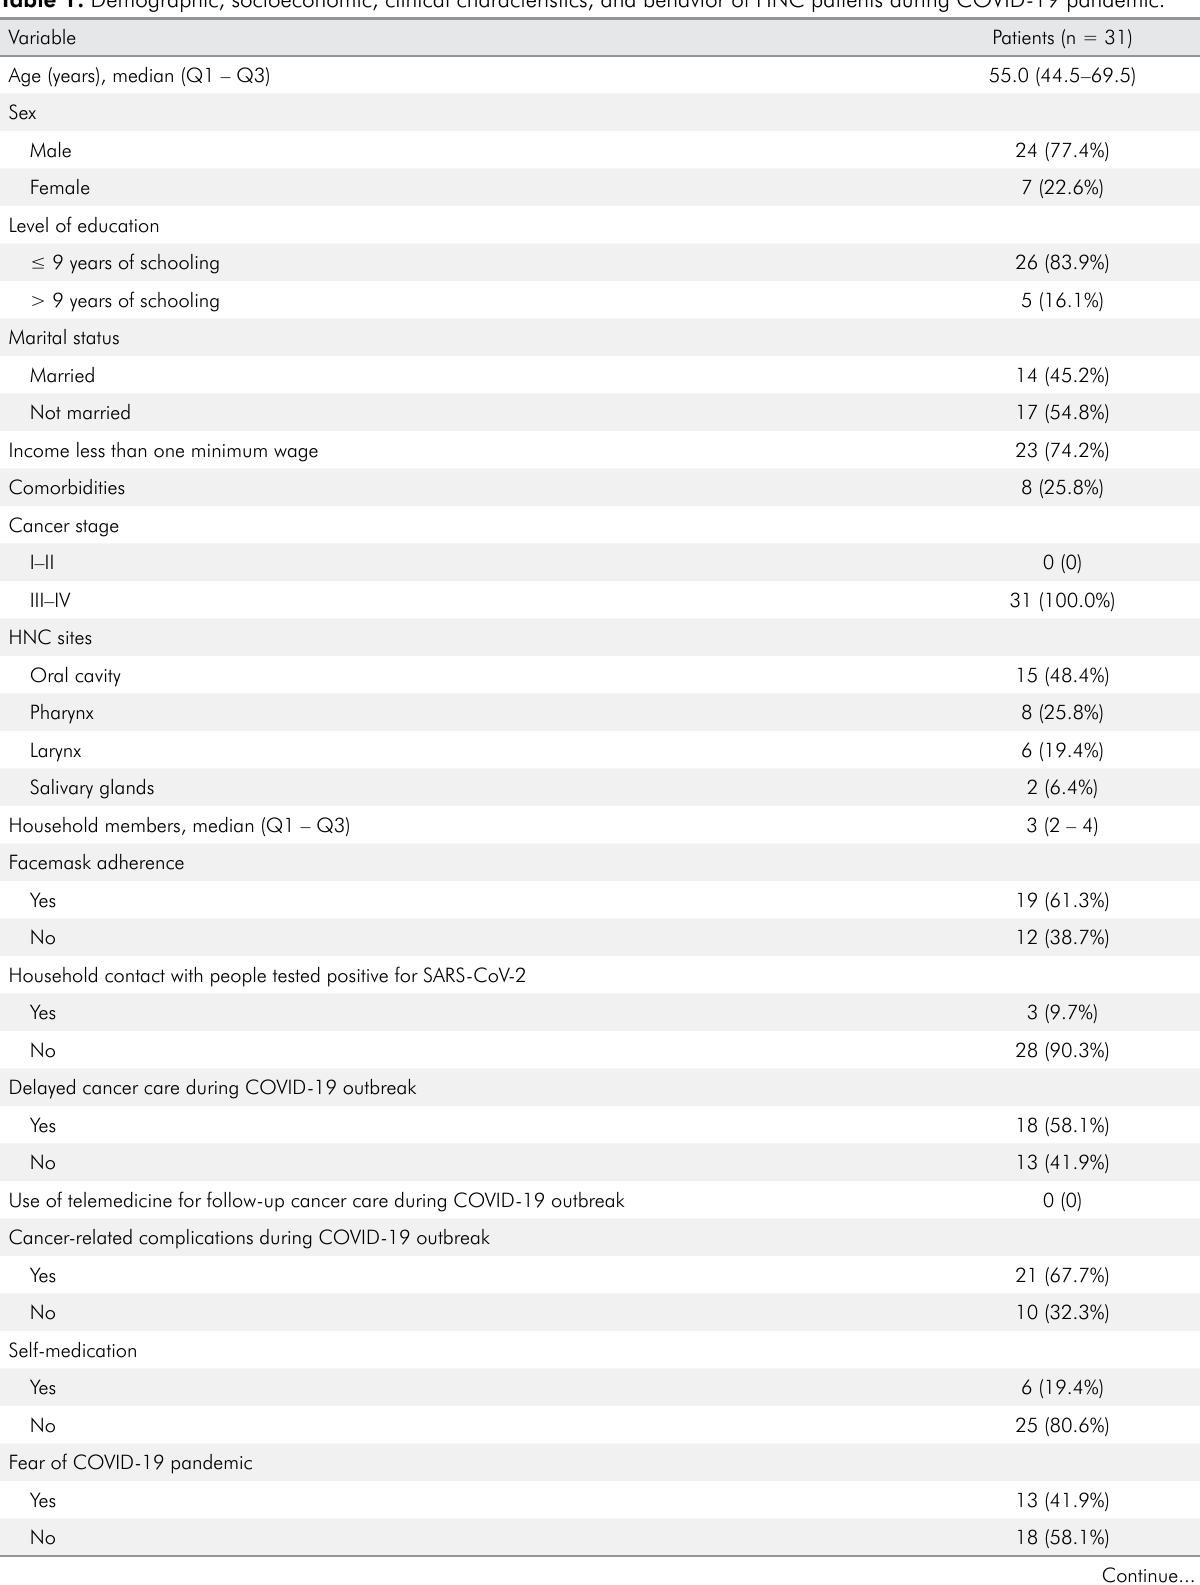
Table 1. Demographic, socioeconomic, clinical characteristics, and behavior of HNC patients during COVID-19 pandemic.